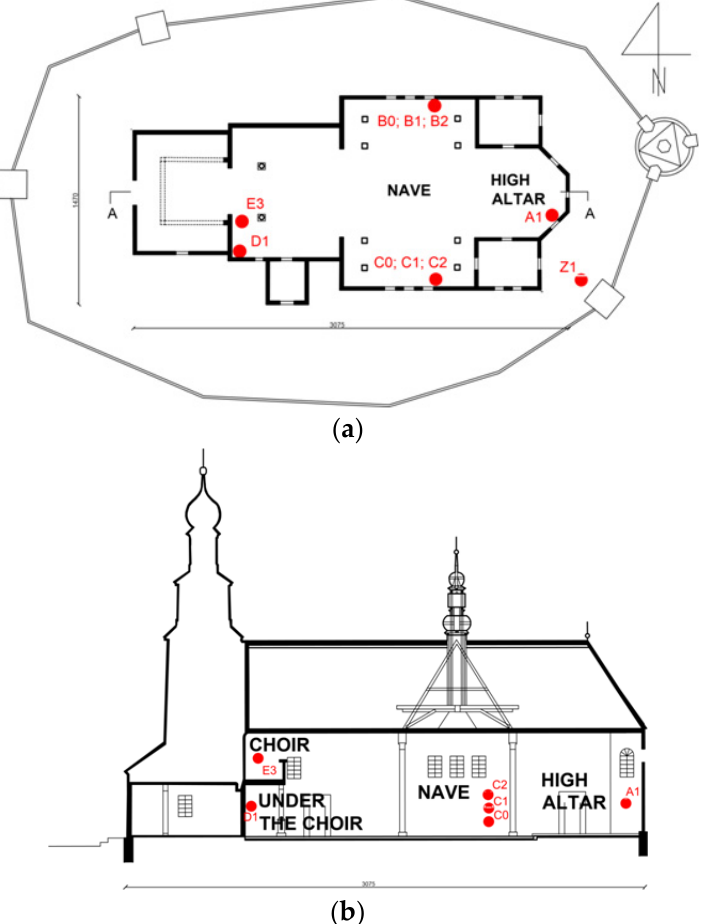
Figure 2. Location of measurement points:( a ) plan of the church,( b ) cross-section of the church.